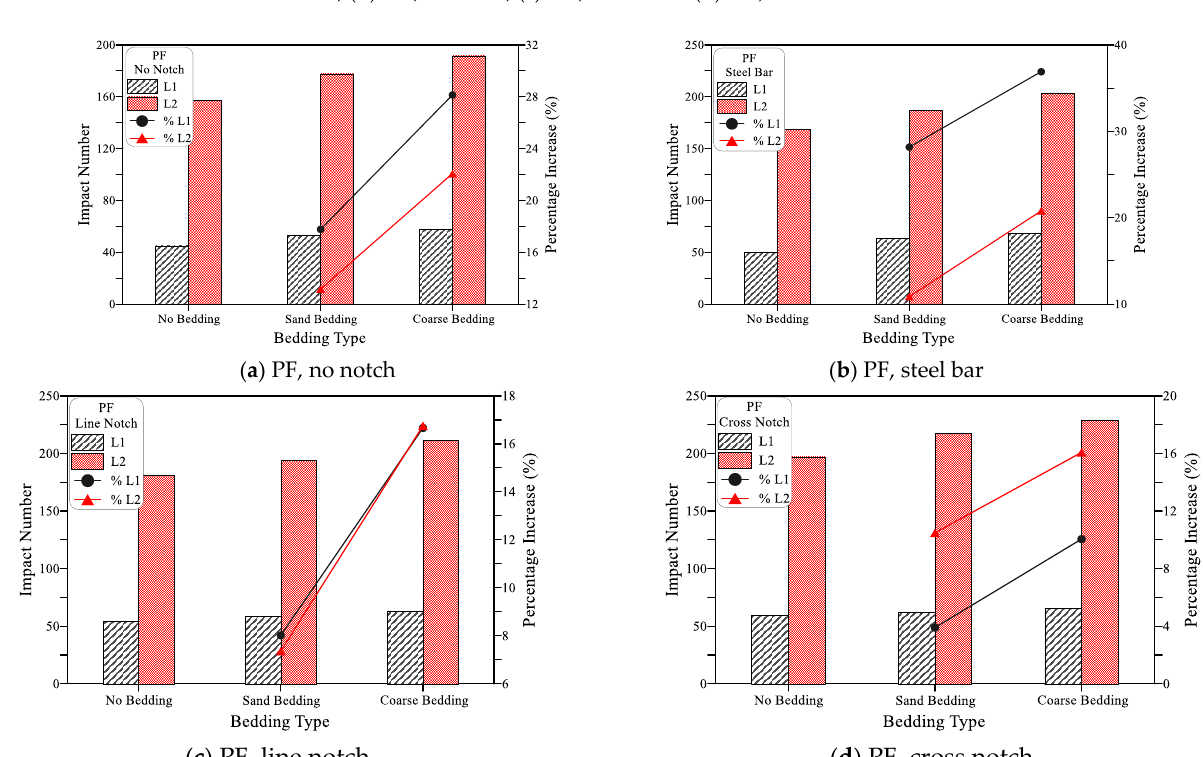
Figure 17. Bedding type effect on cracking and failure impact numbers of PF specimens ( a ) PF, no notch, ( b ) PF, steel bar ( c ) PF, line notch ( d ) PF, cross notch